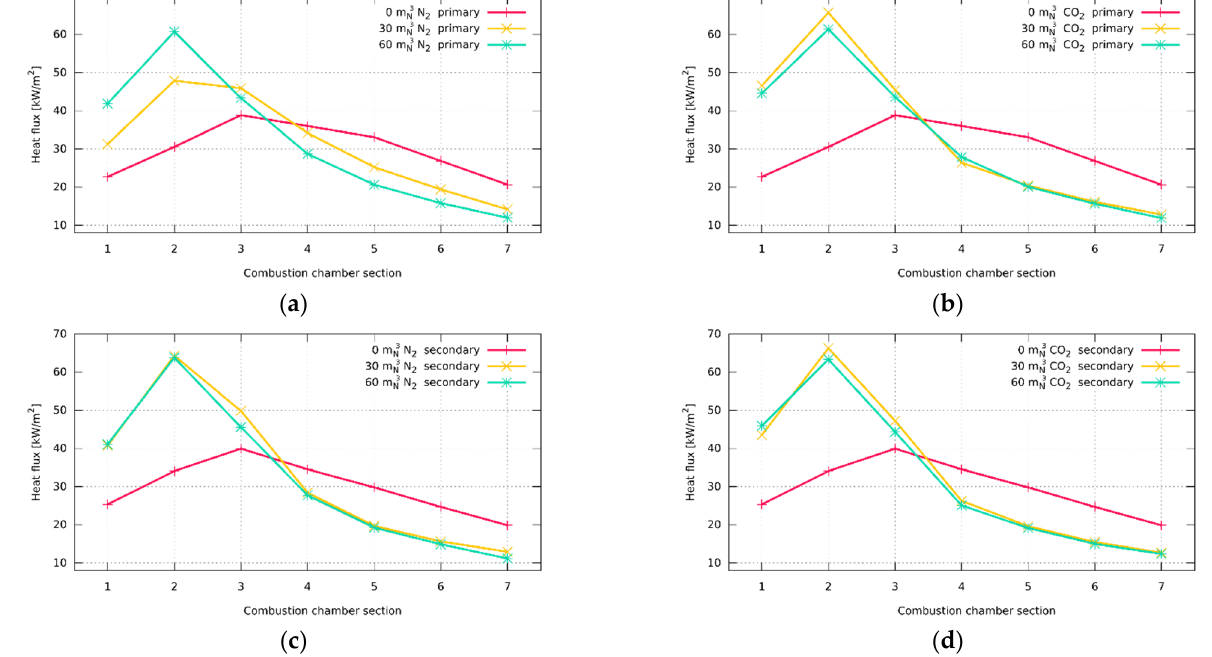
Figure 12. Influence of inert gas addition on heat flux distribution—burner with staged air distribution—Burner B: ( a ) nitrogen addition—primary regime; ( b ) carbon dioxide addition—primary regime; ( c ) nitrogen addition—secondary regime; ( d ) carbon dioxide addition—secondary regime.